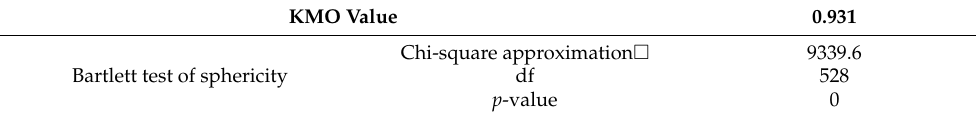
Table 4. KMO and Bartlett’s test.